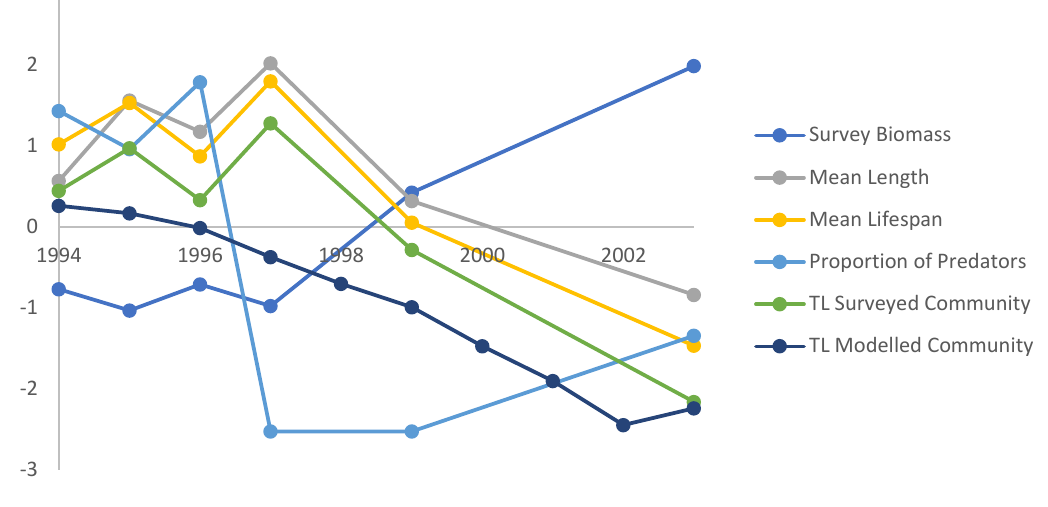
Figure A1: Time series plot of indicators values for Period 2